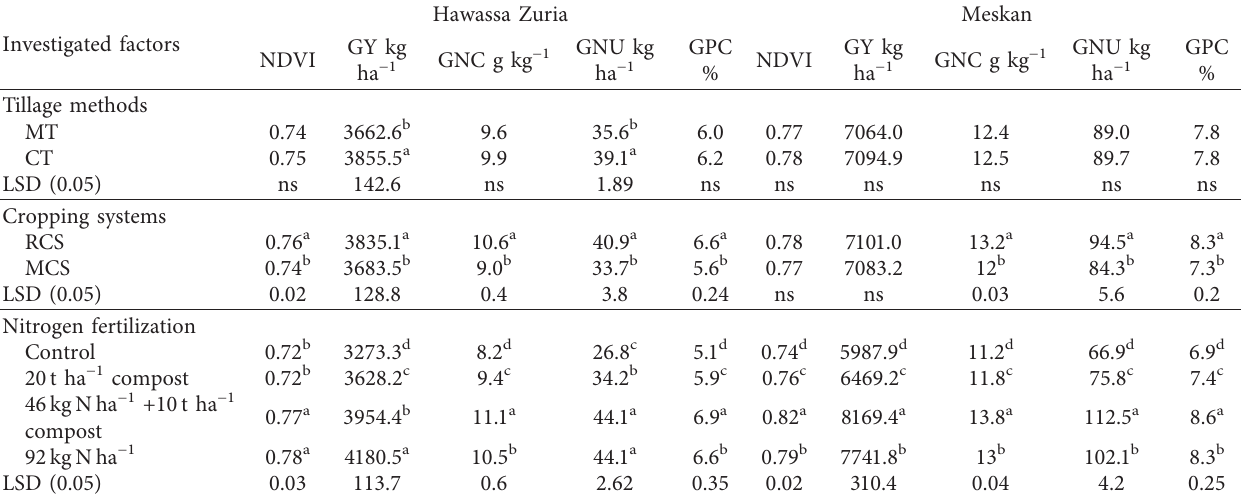
Table 4: The effects of tillage methods, cropping systems, and N-fertilization on NDVI, grain yield, N-content, N-uptake, and grain protein content of maize at the two sites Investigated